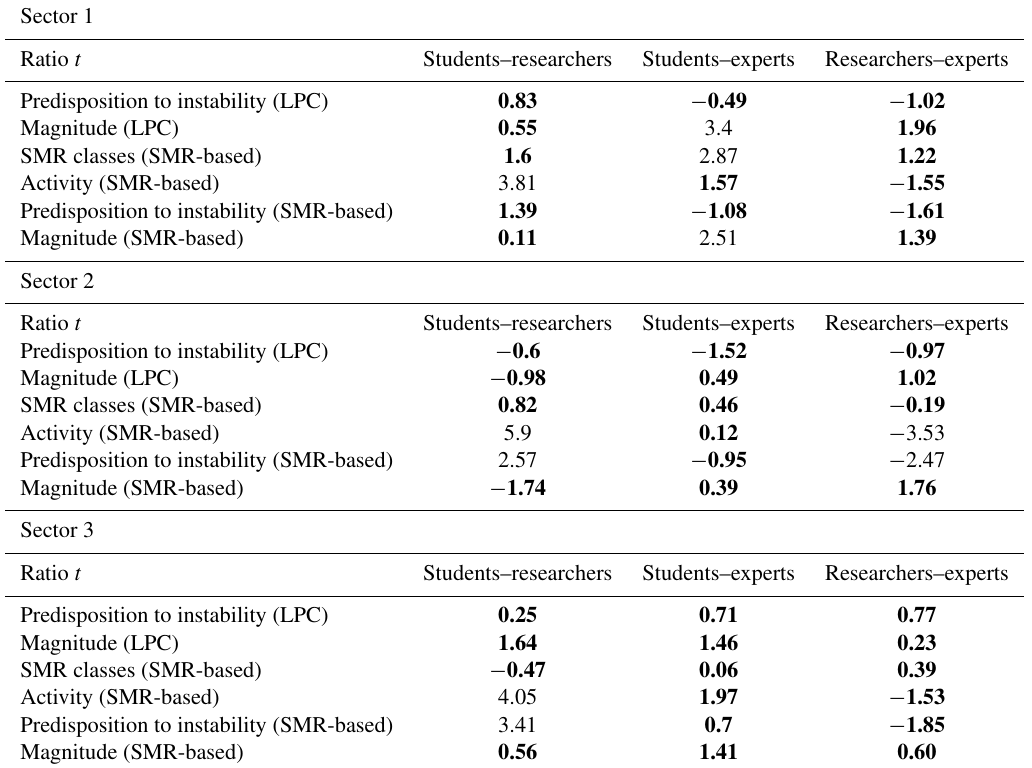
Table 15. Values of the t ratio, to compare the average 2 by 2 of the parameters of the LPC and SMR-based methods. The bold values correspond to the population means that cannot be significantly differentiated (or can be considered as equal).